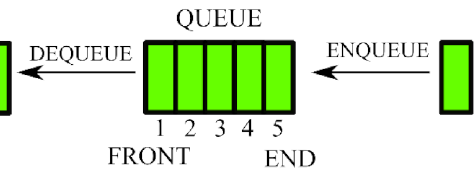
Figure 3. Schematic diagram of the queue memory operation (FIFO principle). A new element added to the queue is placed at the end of the queue, and the first element is removed from the front of the queue. The operation of adding a new element to the queue is called ENQUEUE, while the operation of removing an element from the queue is called DEQUEUE. Abbreviations: 1, 2, 3, 4, 5 denote the positions of the elements that are in the